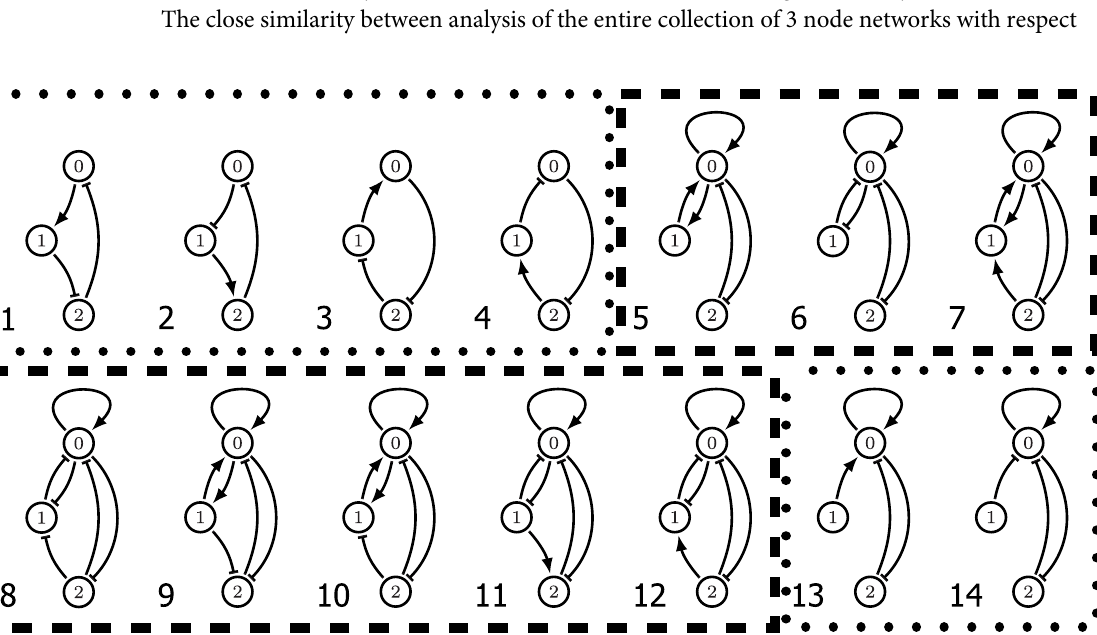
PLOS Computational Biology | https://doi.org/10.1371/journal.pcbi.1009189 July 29,